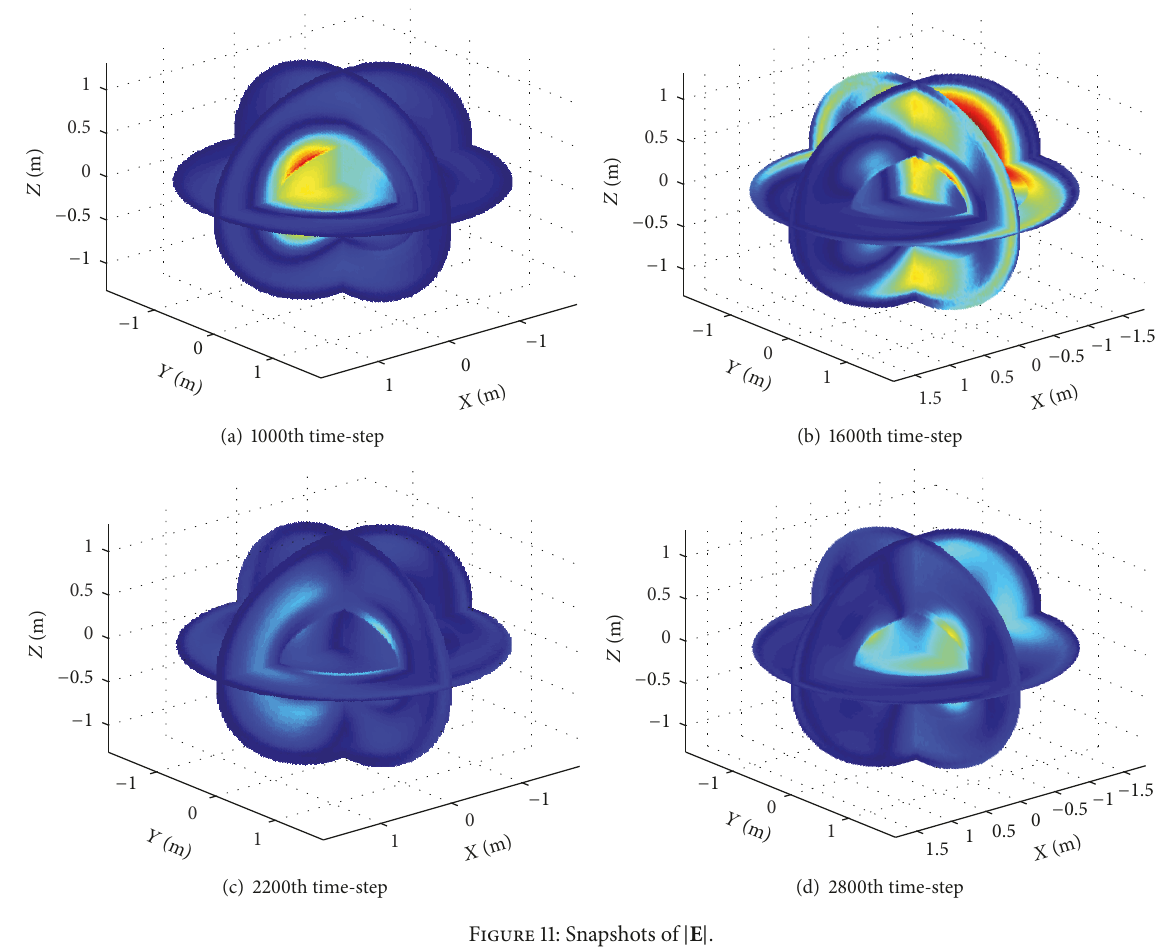
Figure 11: Snapshots of | E |